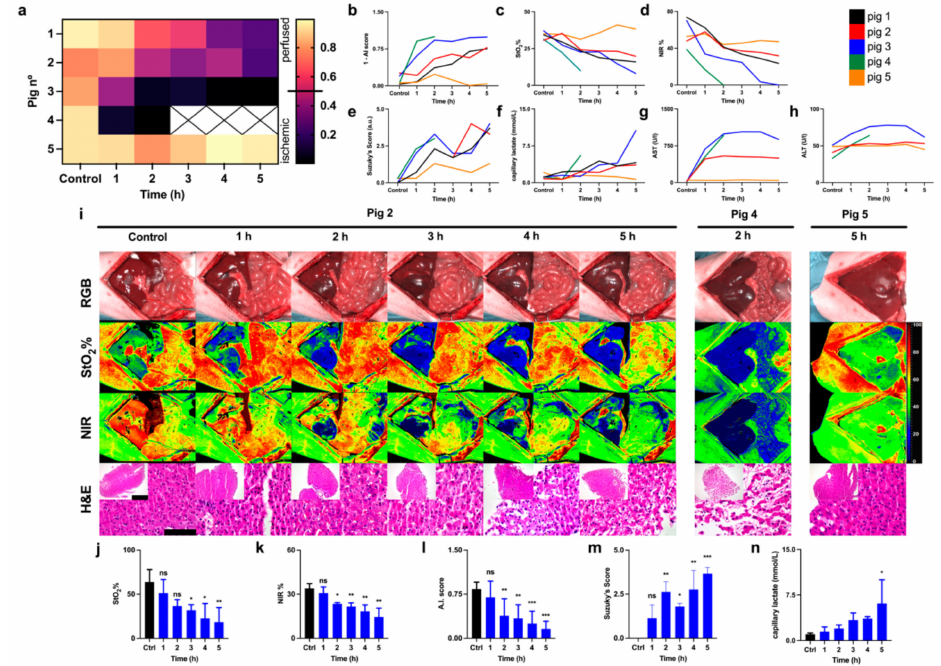
Figure 4. Reperfusion phase. ( a ) Automatic AI score of liver viability for each pig for control and reperfusion times. ( b ) Visualization of AI scores for each pig as a function of time ( y -axis was flipped to provide a better visual comparison with Suzuki’s score ( c , d ) StO 2 % and NIR indexes ( n = 5). ( e ) Suzuki’s score ( n = 5). ( f ) Capillary lactate ( n = 5). ( g ) AST ( n = 4). ( h ) ALT ( n = 4). ( i ) HSI images and H&E images. Pig 2 showed a gradual parenchymal disruption; pig 4 died after 2 h, HSI and H&E showed tissue ischemia and parenchymal disruption respectively. Pig 5 was healthy at the end of the procedure; here, HSI showed a perfused liver and H&E confirmed normal parenchyma. Pigs 1, 2, 3 were grouped ( n = 3). ( j , k ) Indexes of StO 2 % and NIR showed a significant decrease together with ( l ) the AI score. ( m ) Suzuki’s score and ( n ) capillary lactates showed an opposite significant trend. Data are compared to the control, ns p > 0.05, * p ≤ 0.05, ** p ≤ 0.01, *** p ≤ 0.001, ( n = 5). Histology photos were taken with a Leica DM2000 LED microscope, magnification 40 × and 10 × , scale bars 100 µ m and 200 µ m